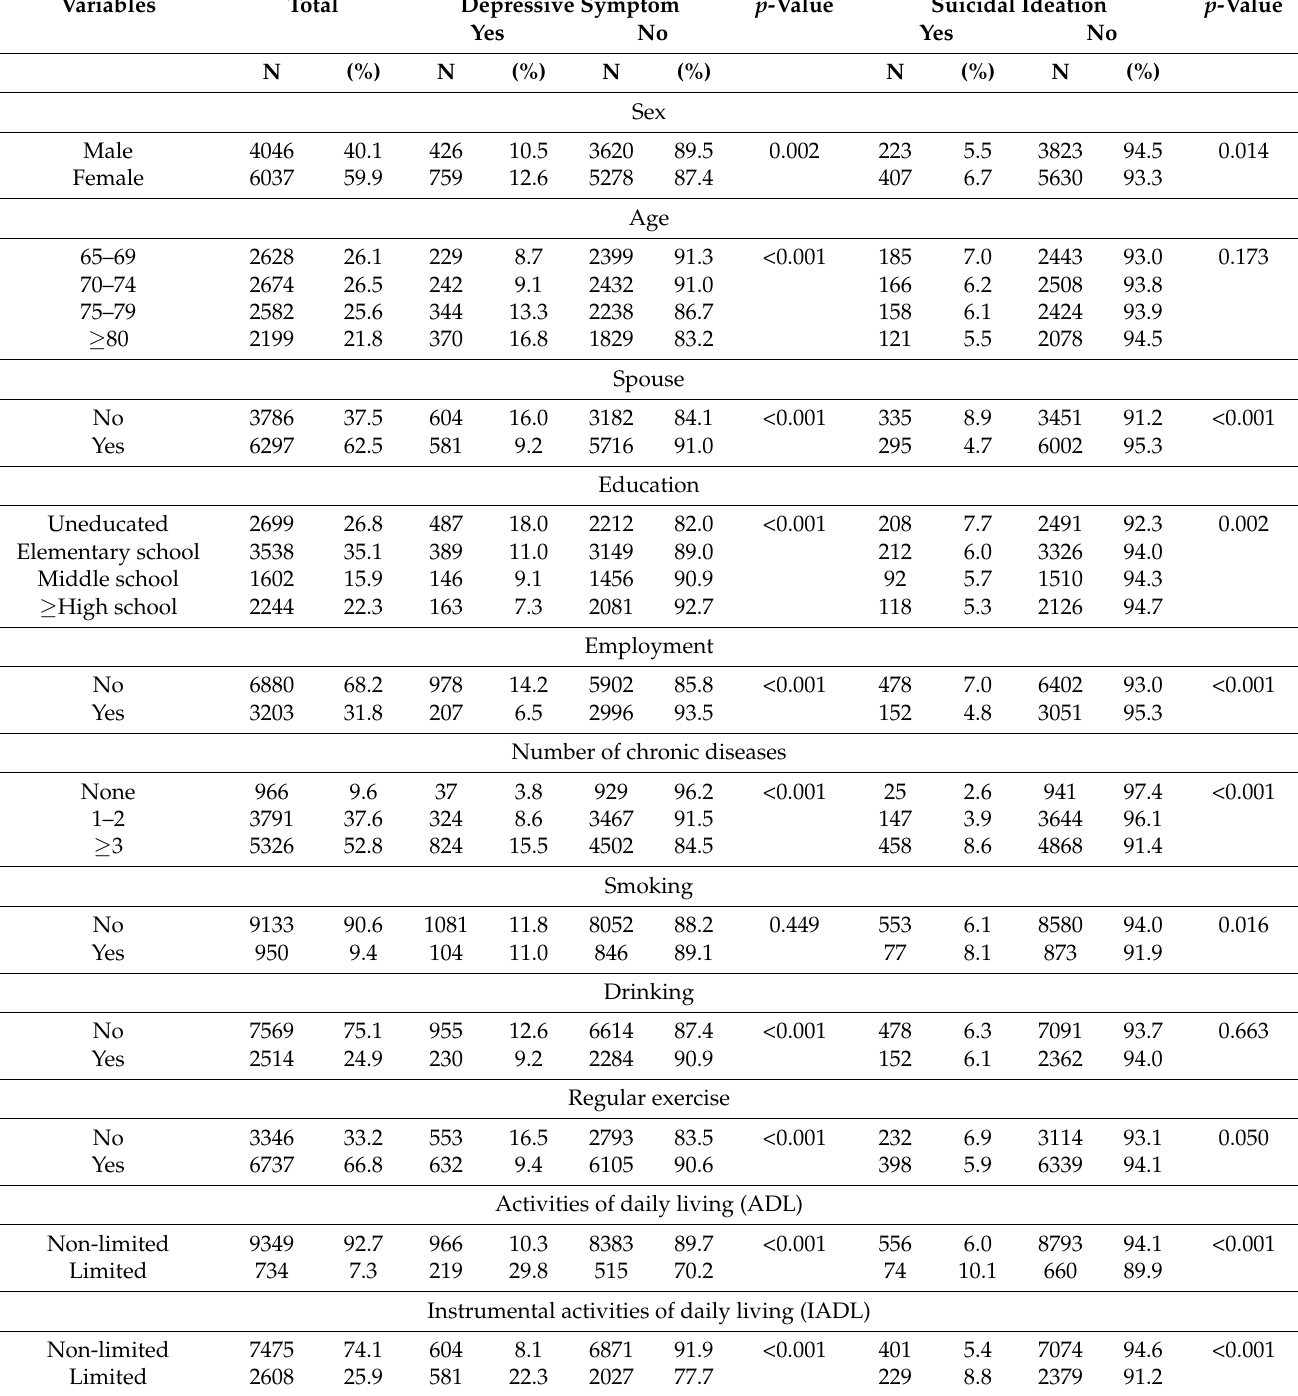
Table 1. General characteristics of the study population (N =